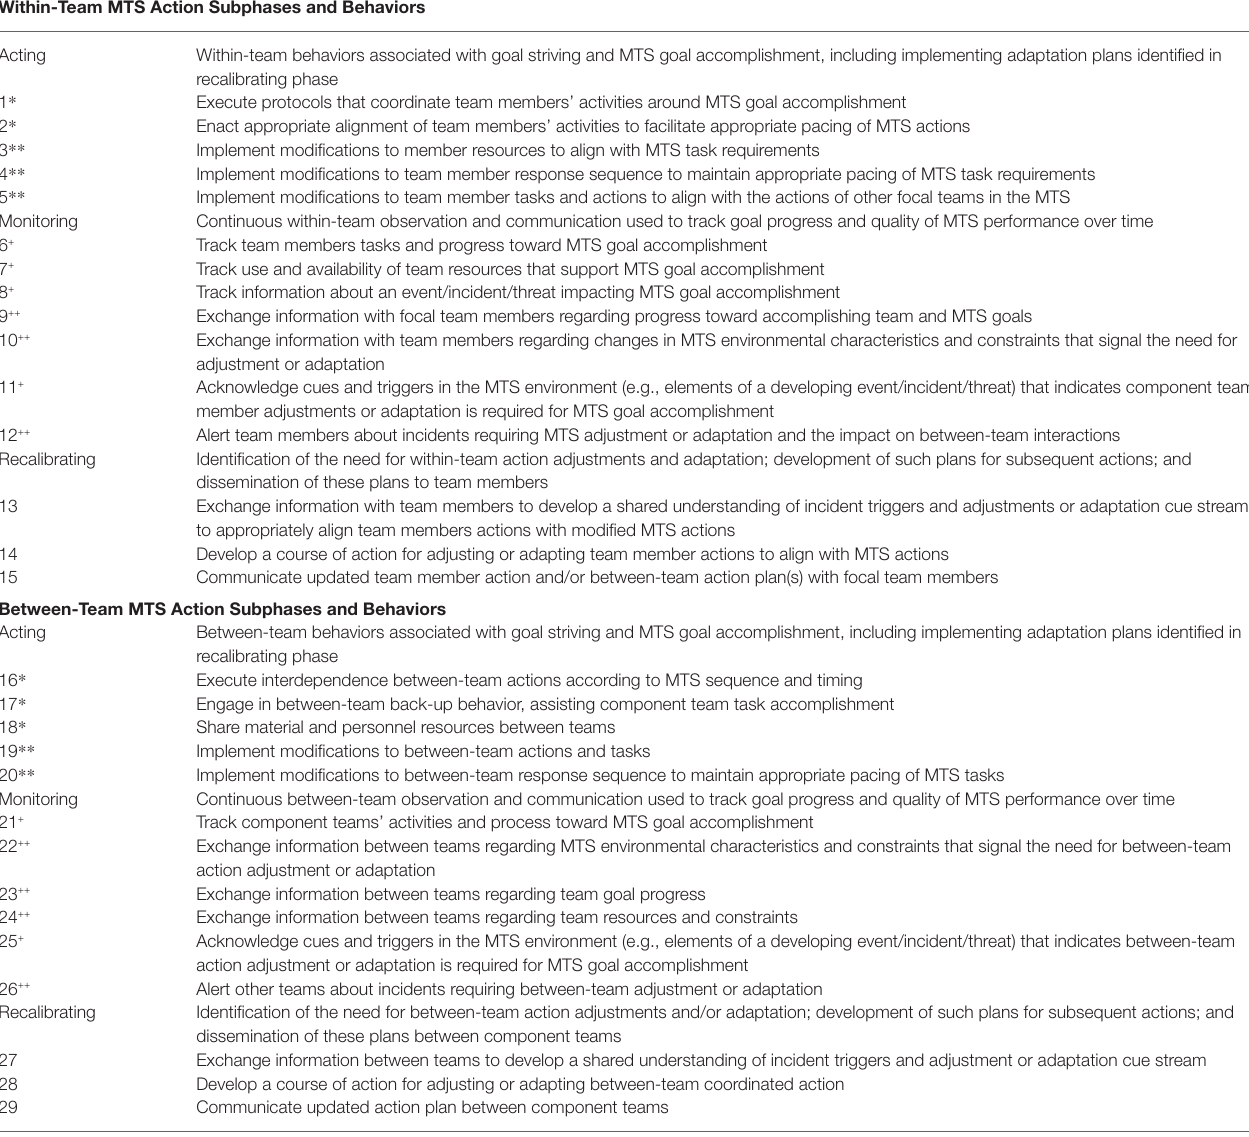
TABLE 1 | MTS Action Subphase Behavioral